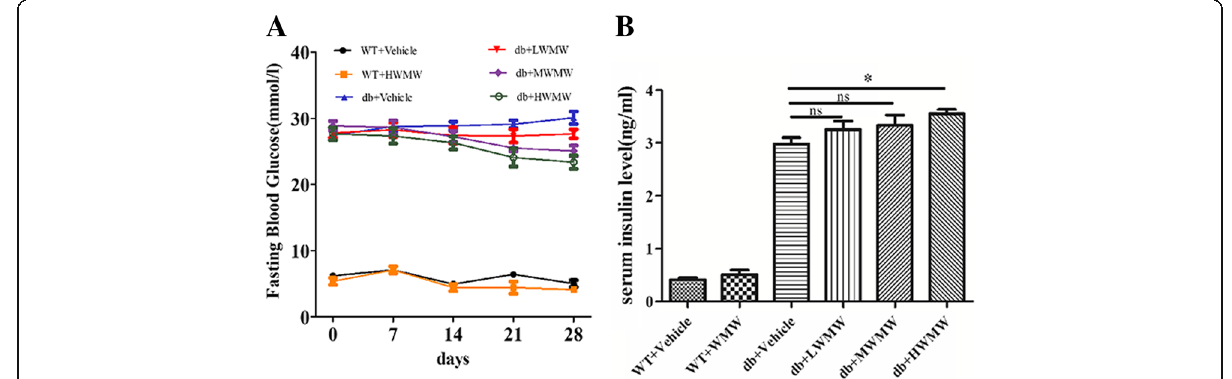
Fig. 2 Effect of WMW on FBG and serum insulin levels in db/db mice. Representative graphs were ( a ) FBG ( n = 6) and ( b ) serum insulin (n = 6). LWMW, MWMW, and HWMW shows mice treated with 4800, 9600, and 19,200 mg/kg/bw WMW, respectively. WT + HWMW shows wild-type mice treated with 19,200 mg/kg/bw WMW, P < 0.05(*); no significance